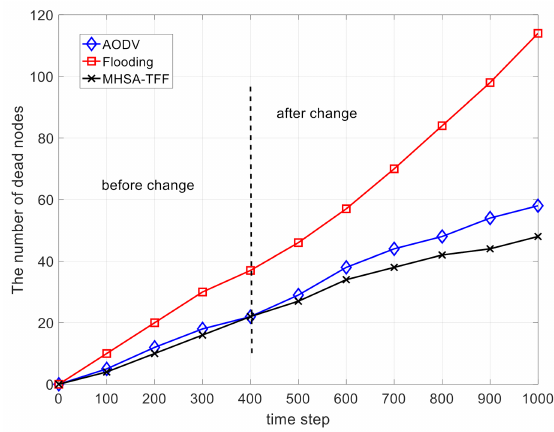
Figure 7. The comparison on the number of dead